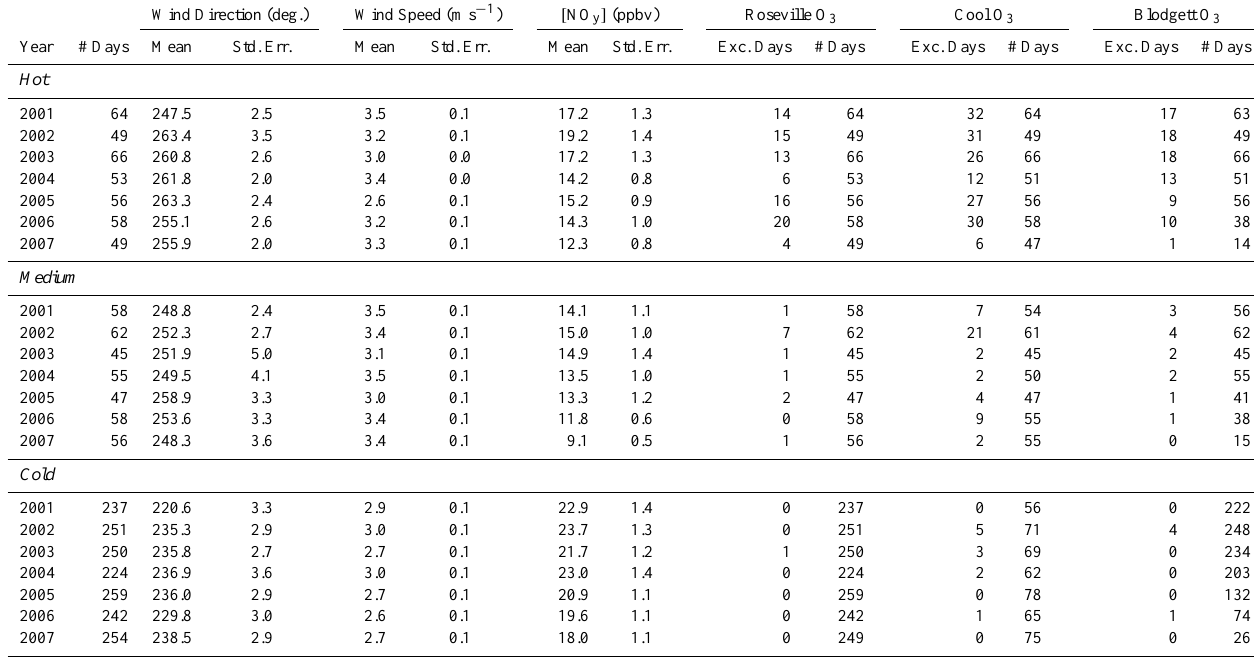
Table 2a All Data (Full